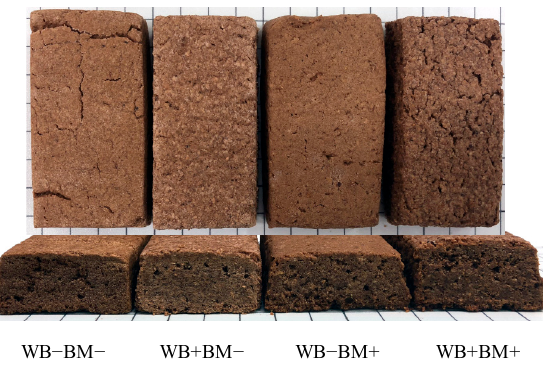
Figure 2. Features of the test foods.